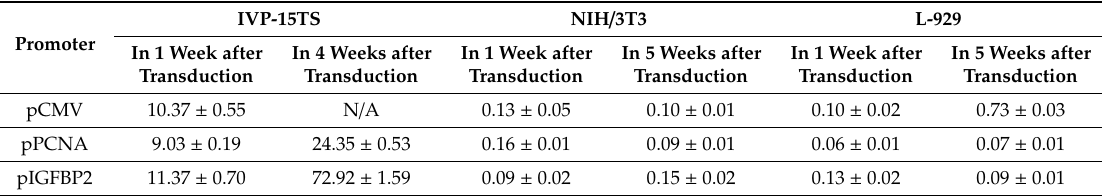
Table 1. Values of the 50% inhibitory concentration (IC 50 , µ M) of ganciclovir in transduced cells that contain the transgene HSVtk-CopGFP under the control of pCMV, pPCNA, and pIGFBP2. Cell viability was measured by MTS